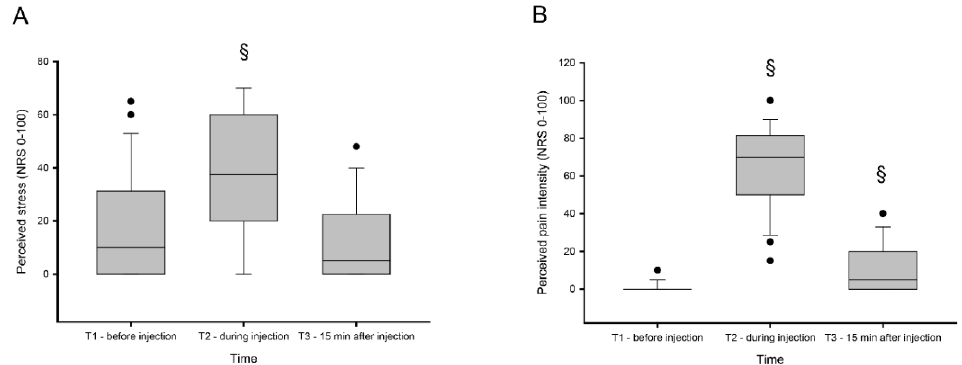
Figure 2. Perceived stress and pain. Perceived stress ( A ) and pain ( B ) levels measured on 0–100 numeric rating scale (NRS) before (T1), during (T2), and 15 min after (T3) experimentally-induced muscle pain by injection of hypertonic saline 0.4 mL (56.5 mg / mL) into the masseter muscle. § indicates significant di ff erence when compared to